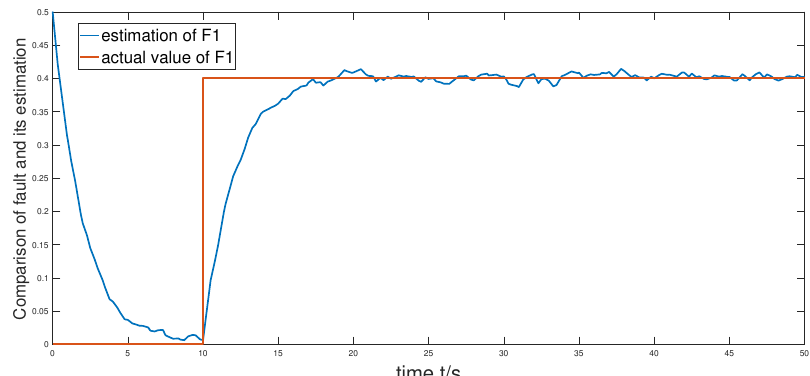
Figure 5. Comparison of fault F 1 and its estimation ˆ F 1 .